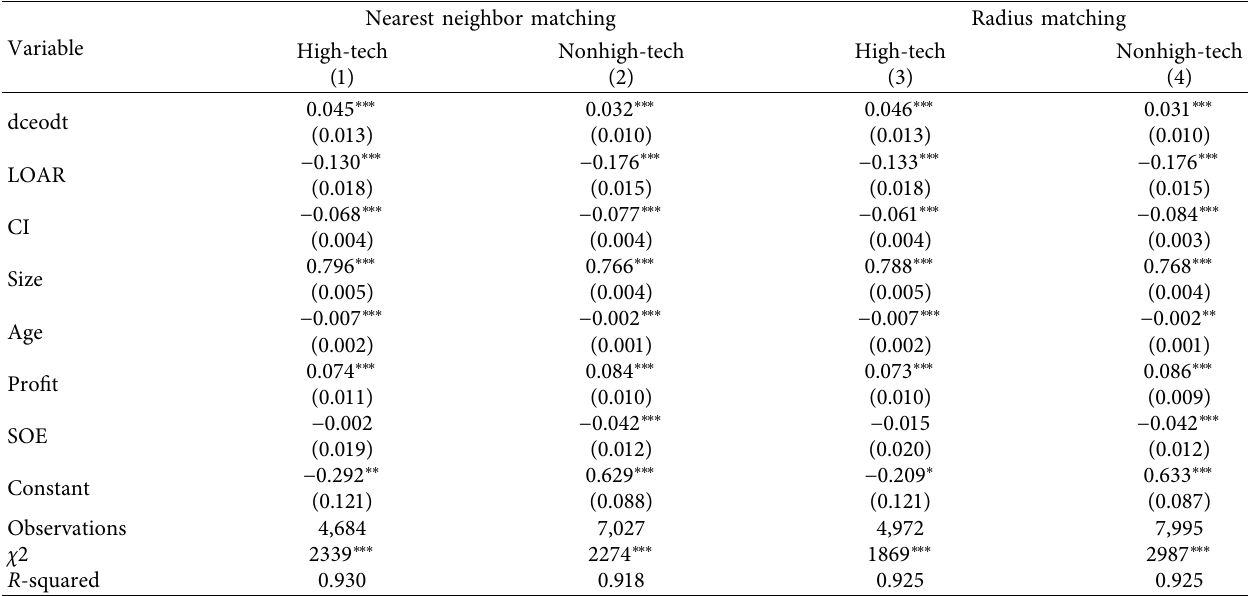
Table 5: Heterogeneity results for high-tech and nonhigh-tech